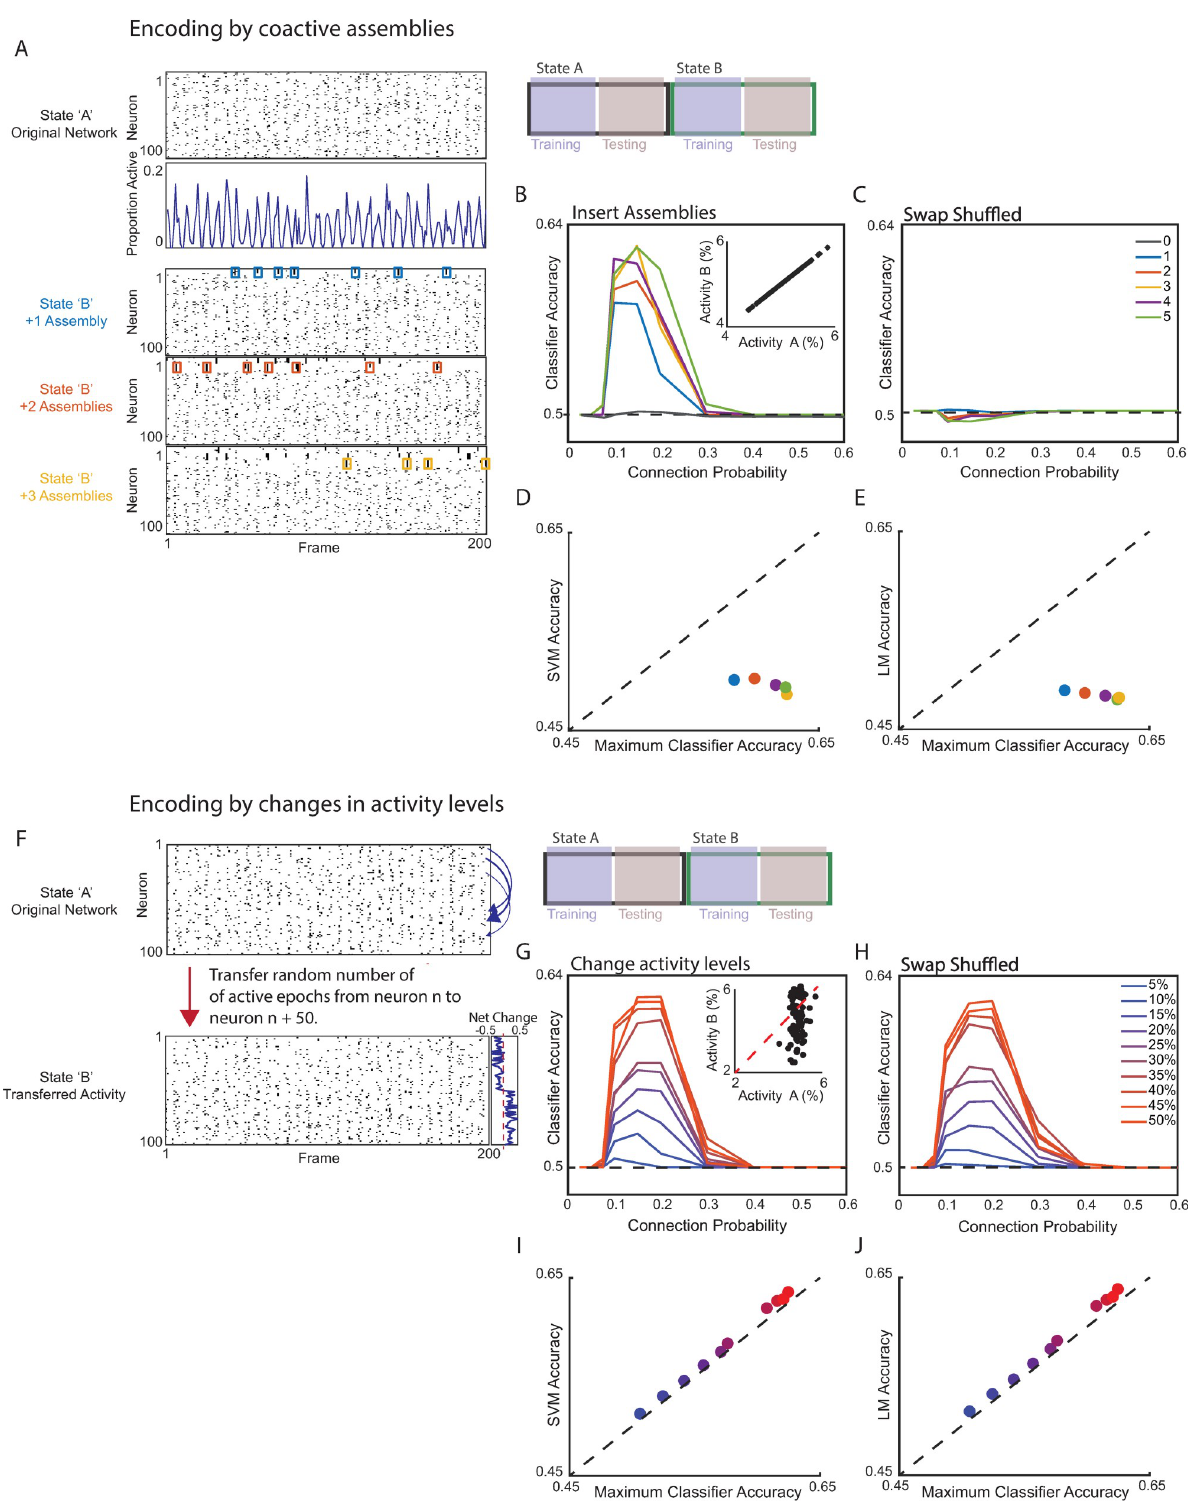
Fig 4. Neural network classifiers can distinguish states which differ in either activity or correlations. (A) We generated synthetic datasets consisting of 100 neurons. Each dataset consisted of 2 activity rasters, corresponding to States “A” and “B.” Each raster contained 6,000 time points (frames). The overall level of activity in each raster oscillated around a mean level (5% of neurons active in a frame). In “State A,” neuronal activity was